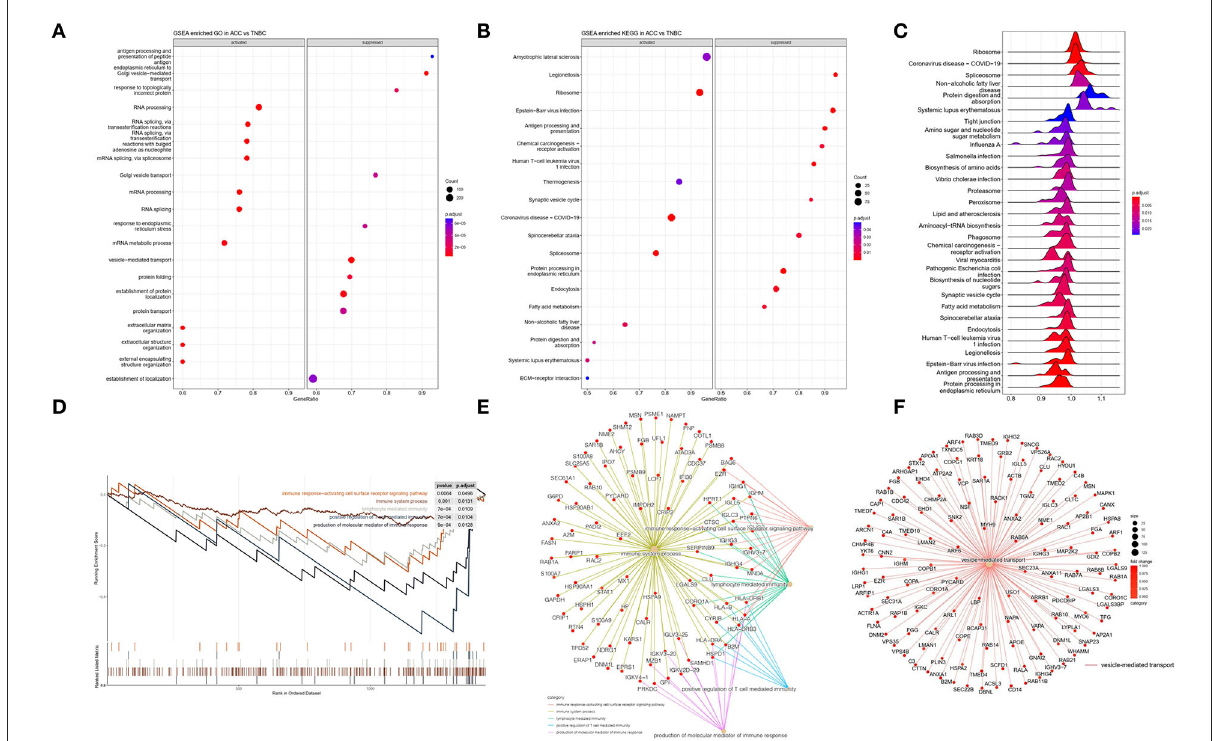
FIGURE5 (A) GSEA enriched GO analysis in ACC vs. BL-TNBC. GO annotations showing the top activated and suppressed GO terms based on biological process (BP). Significant proteins were included using p < 0.05, Benjamini–Hochberg correction (BH), gene set size 10–500, and the whole protein list as the background set. Bubble indicates significant terms by the gradient legend as p -adjust < 0.001, and the x-axis refers to gene ratio and the number of proteins contained in given enriched terms. (B) GSEA enriched KEGG analysis in ACC vs. BL-TNBC. The top